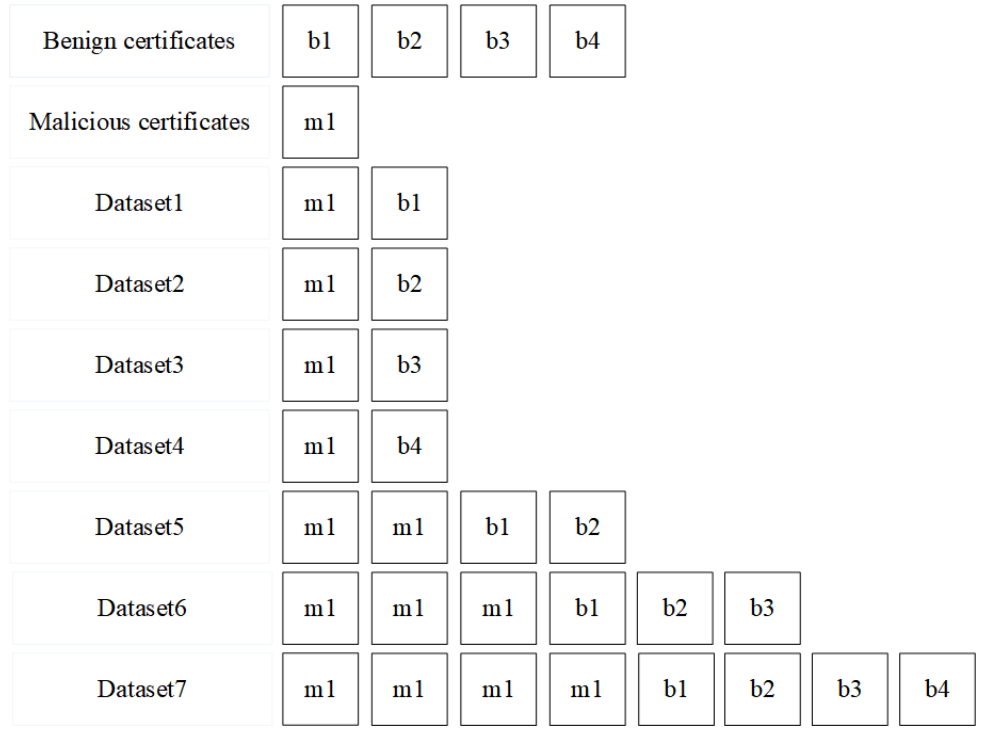
Figure 4. The combination of different